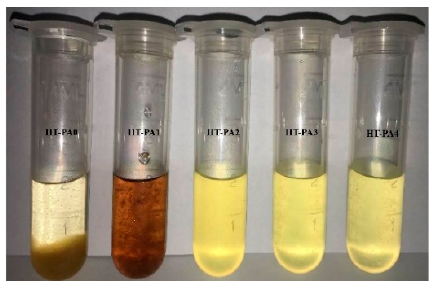
Figure 15. Digital photo of the solubility of polyamides in DMF solution. Reproduced from Reference [71].